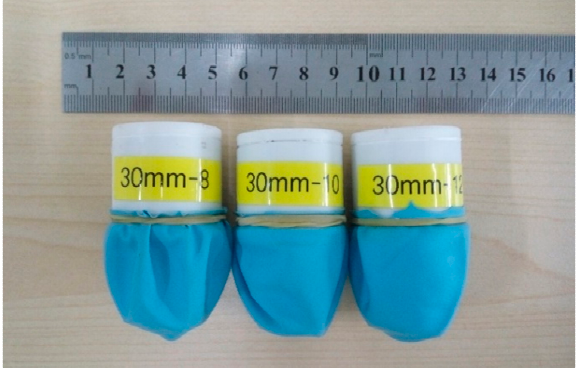
Figure 14. Three CTSA-II hands with different numbers of pin assemblies.